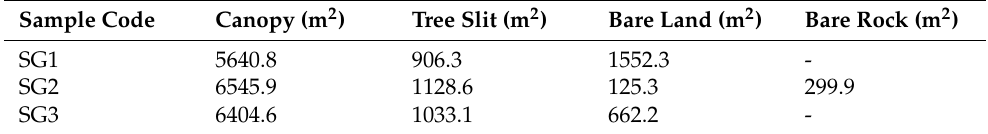
Table A1. The area of each square classification results on the surface outside the Shenxiantang